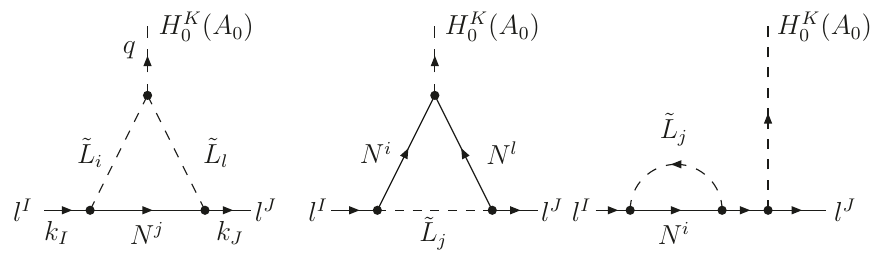
! ‘ I (cid:22) ‘ J and A 0 ! ‘ I (cid:22) ‘ J decays in 0